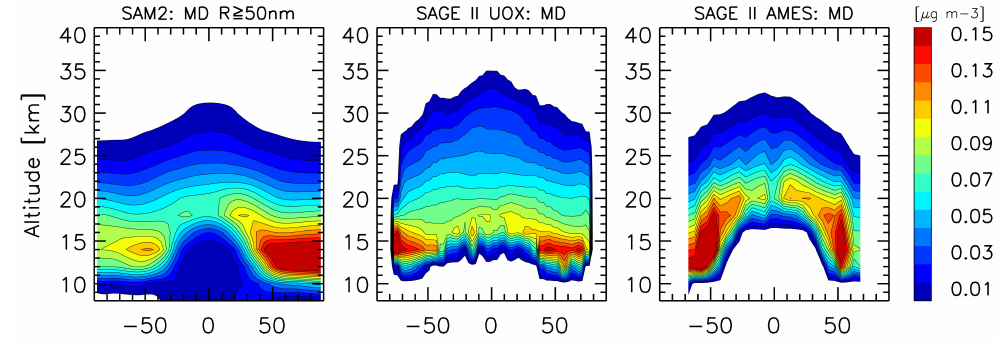
Fig. 10. As in Figure 9, except for aerosol mass